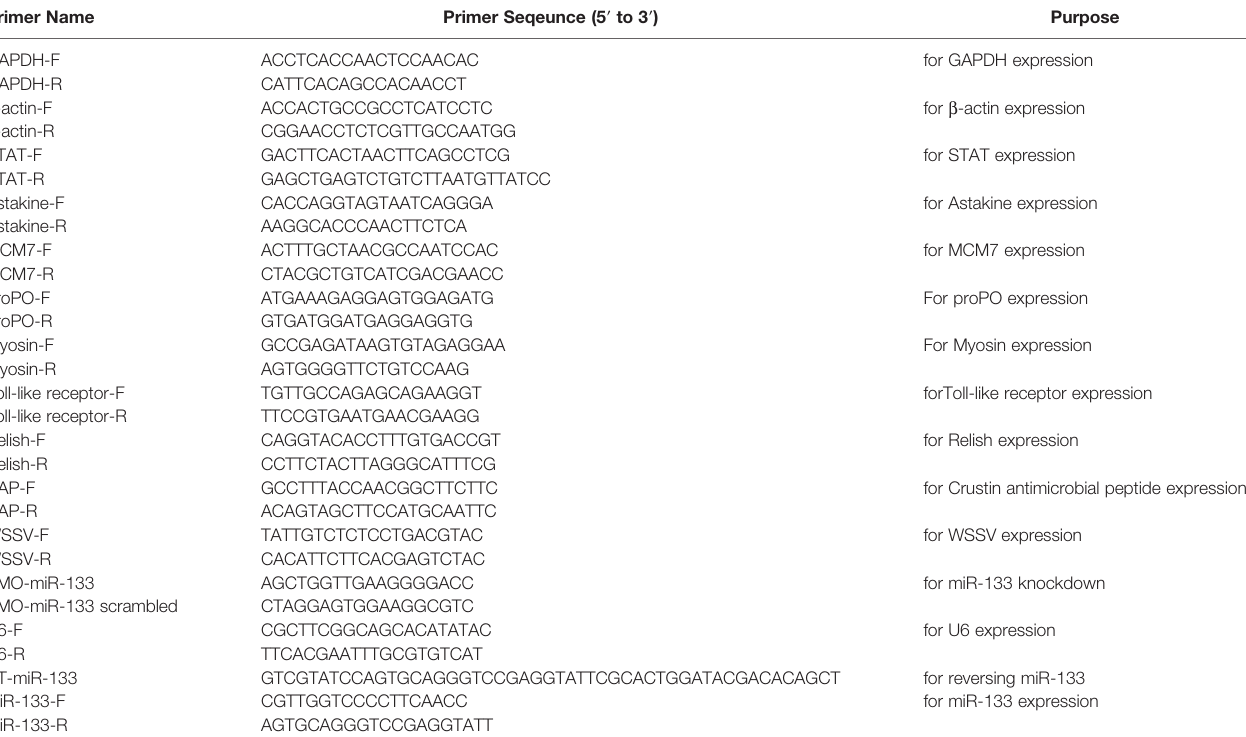
TABLE 1 | Universal and speci fi c primers used in this